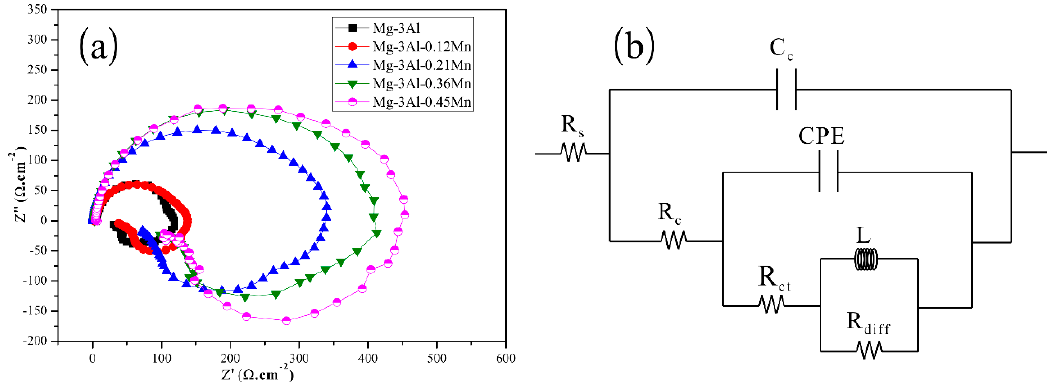
Figure 13. The electrochemical impedance spectrum (EIS) results of the Mg-3Al- x Mn alloys in 3.5 wt.% NaCl solution: ( a ) Nyquist plots, ( b ) the equivalent circuit. Table 5. Fitting results of the EIS data for the Mg-3Al- x Mn alloys.